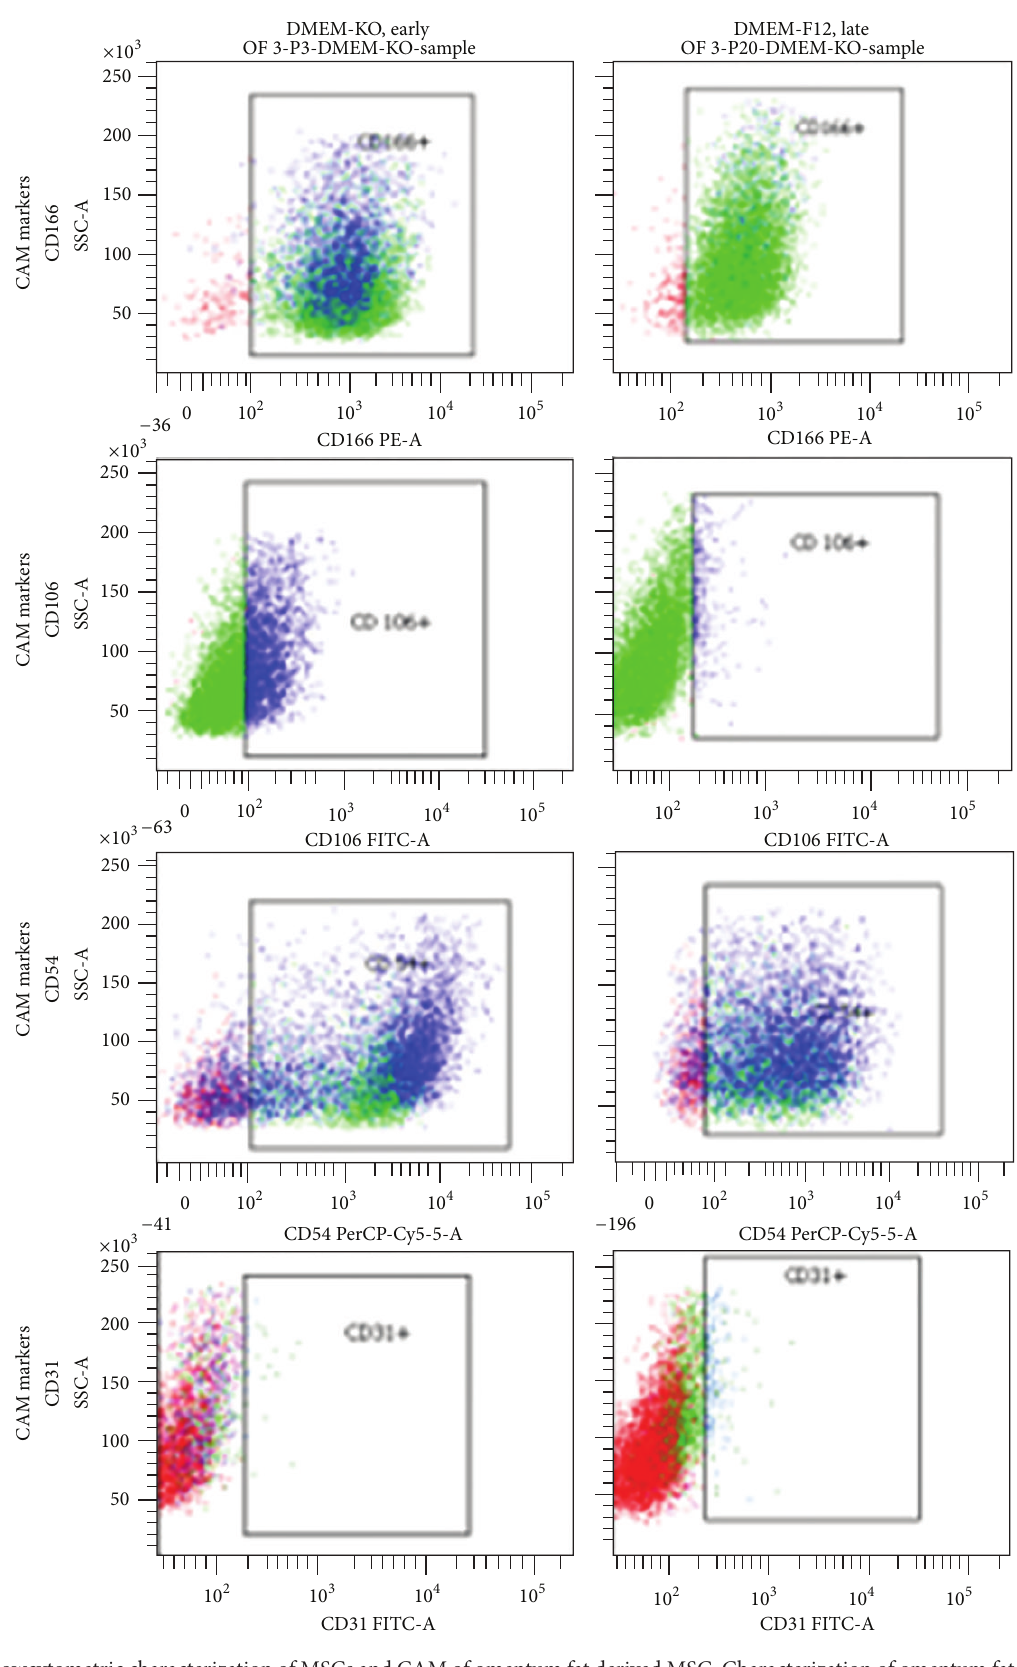
Figure 2: Flowcytometric characterization of MSCs and CAM of omentum fat derived MSC. Characterization of omentum fat derived MSC at early (P3) and late (P20) passages in DMEM-LG, Alpha-MEM, DMEM-F12, and DMEM-KO for CD90, CD105, CD73, CD29, CD49d, CD44, CD166, CD106, CD54, and CD31 using